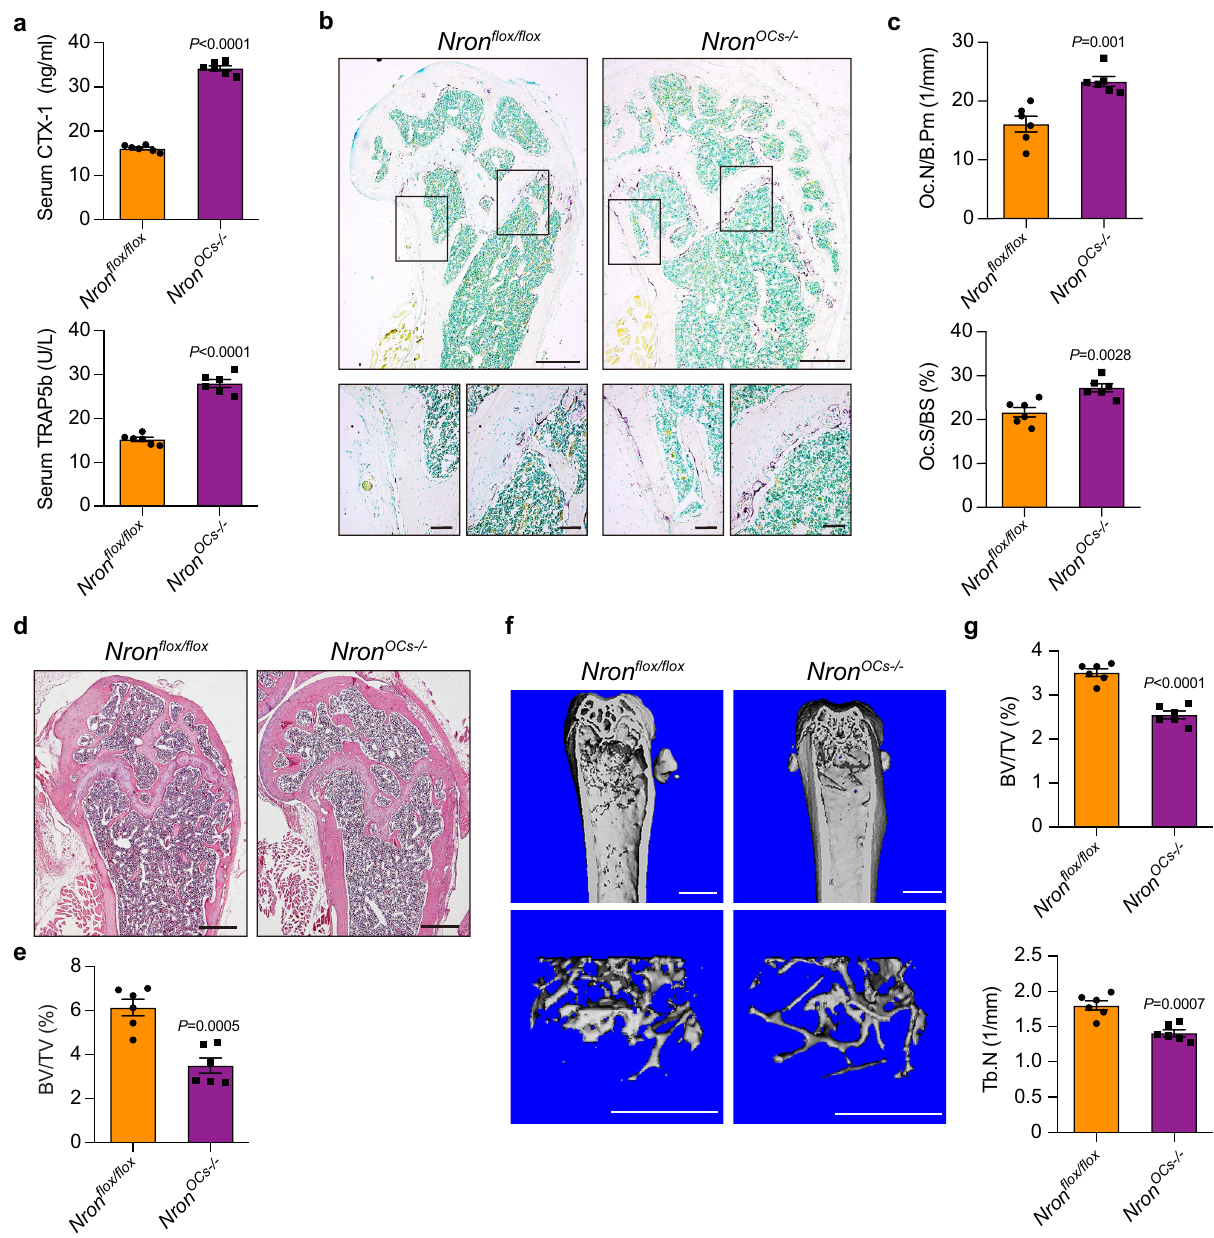
Fig. 2 Osteoclast-speci fi c Nron knockout activated bone resorption in mice. a Serum CTX-I and TRAP5b levels of 6-month-old female Nron fl ox/ fl ox littermates and Nron OCs − / − mice analyzed by ELISA, ( n = 6/group). b Representative TRAP staining images of femurs from 6-month-old female Nron fl ox/ fl ox littermates and Nron OCs − / − mice, (similar results were obtained in all mice, n = 6/group). Scale bar: 500 μ m (upper panels); 100 μ m (lower panels). c Quanti fi cation of osteoclastic metrics in subepiphyseal region of femurs in b : Oc.N/B.Pm osteoclast number per bone perimeter, Oc.S/BS osteoclast surface per bone surface, ( n = 6/group). d Representative H&E staining images of femurs from 6-month-old female Nron fl ox/ fl ox littermates and Nron OCs − / − mice, (similar results were obtained in all mice, n = 6/group). Scale bar: 500 μ m. e Histological measurements of BV/TV values in d , ( n = 6/ group). f Representative μ CT images showing the 3D bone structures of the femurs from 6-month-old female Nron fl ox/ fl ox littermates and Nron OCs − / − mice, (similar results were obtained in all mice, n = 6/group). Scale bar: 1 mm (all panels). g μ CT measurements of BV/TV and Tb.N in femurs from 6-month-old female Nron fl ox/ fl ox littermates and Nron OCs − / − mice, ( n = 6/group). Data are presented as the means± s.e.m. Signi fi cant differences between two groups were determined by unpaired Student ’ s t -test (two-tailed). Source data are provided as a Source Data fi